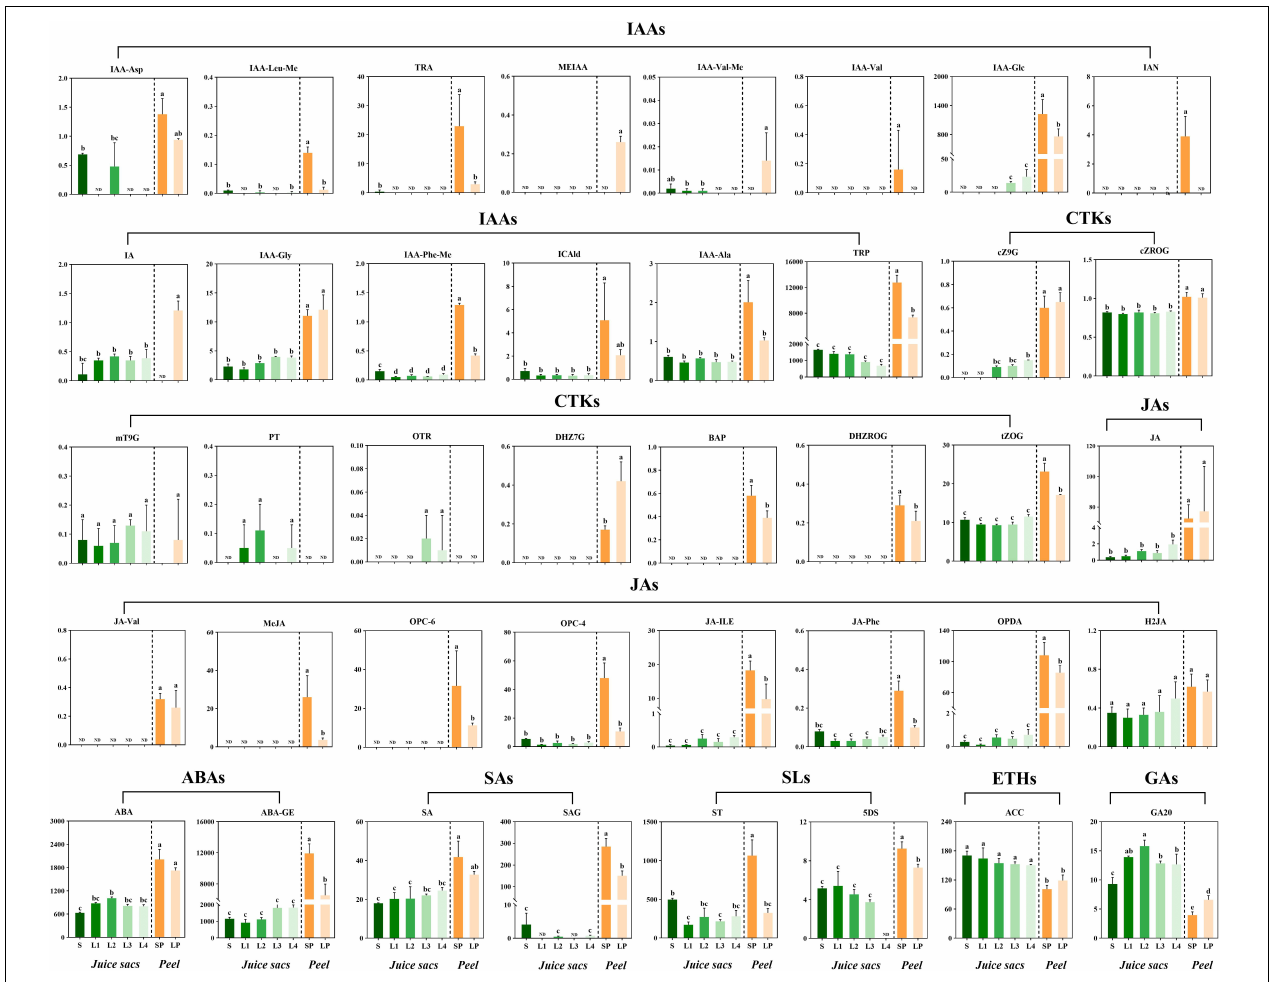
FIGURE 3 | The profiling of phytohormones in the juice sacs and peel of small-size and large-size fruit. Eight classes of phytohormones and/or their metabolites were detected: auxins, cytokinins (CTKs), jasmonic acids (JAs), abscisic acids (ABAs), salicylic acids (SAs), strigolactones (SLs), ethylene (ETHs), gibberellic acids (GAs). S, juice sacs from small-size fruit. L1–L4, juice sacs from large-size fruit, which were classified according to the granulation level. SP, small-size fruit peel. LP, large-size fruit peel. The contents of phytohormones were expressed as ng/g in a fresh weight basis. Data were represented as mean ± standard deviation of three replicates ( n = 3), with 15 fruit in each replicate. Different lowercase letters in each column represented a significant difference at p < 0.05 level by Tukey